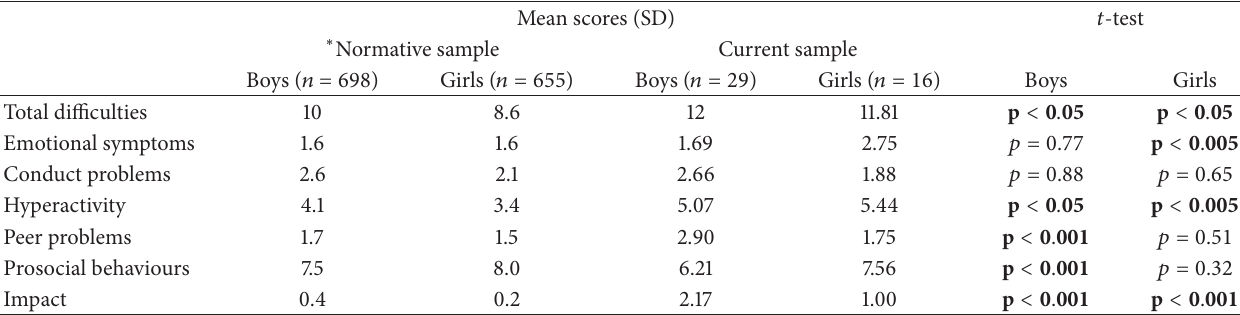
Table 5: SDQ scores by gender compared with a normative sample.